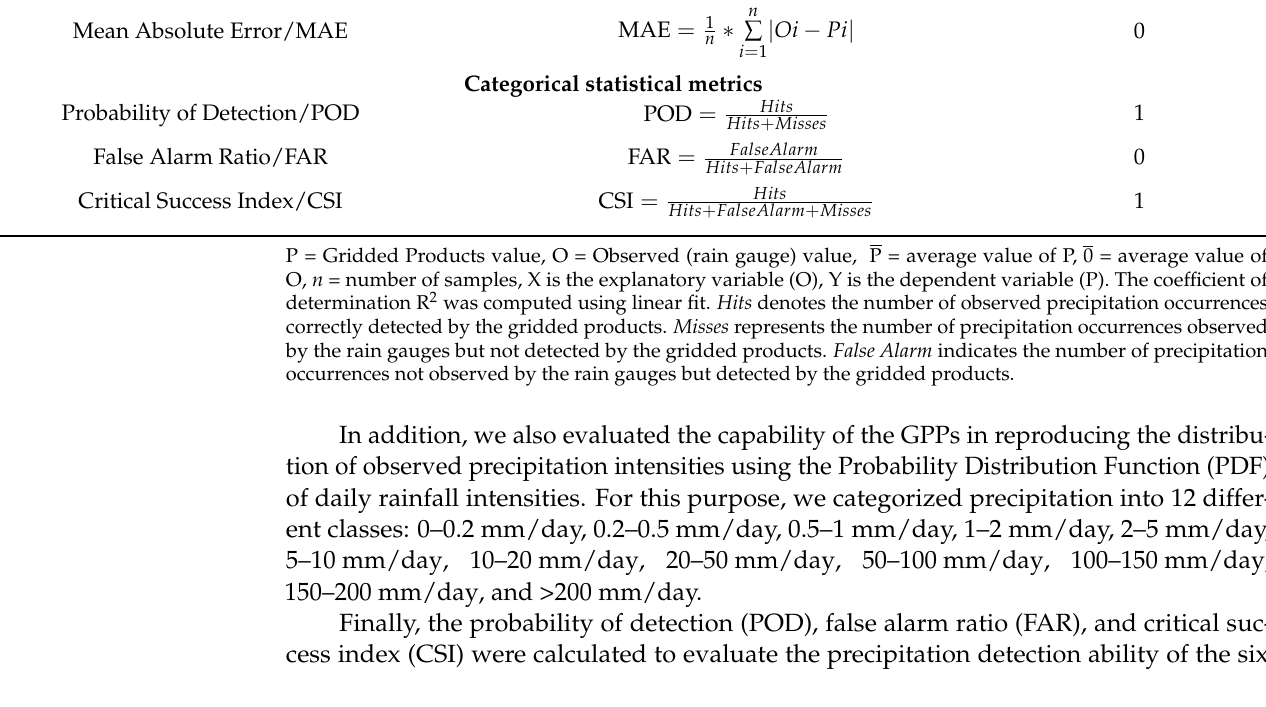
Table 2. Statistical metrics used to quantify GPP performance.